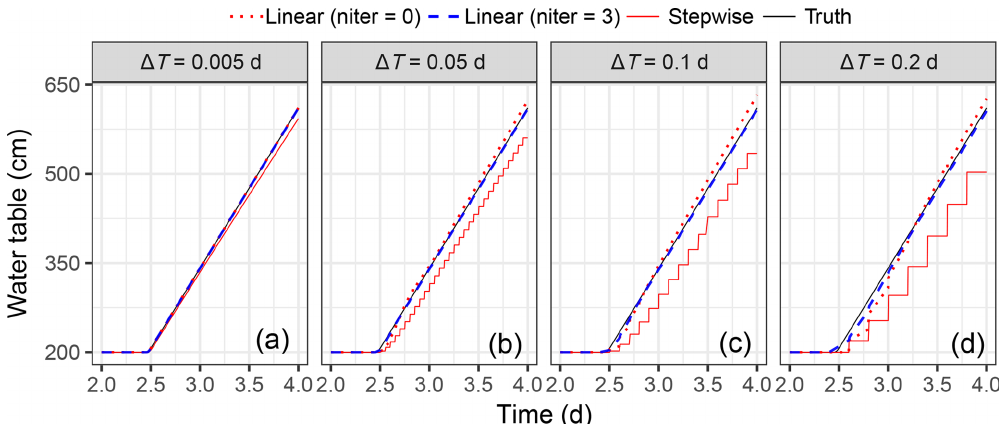
Figure 9. Water table changing with time for different macro-time-step sizes ( (cid:49)T = 0 . 005, 0.05, 0.1, and 0.2 days), in scenario 1, case 1. The HYDRUS-1D solution is taken as the truth. Compared with the stepwise extended method (Seo et al., 2007), the coupling error is significantly reduced by a linear prediction.